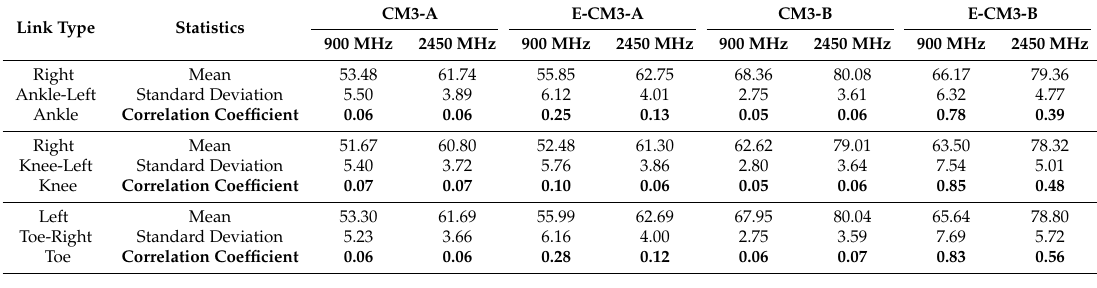
Table 7. Statistical analysis of the IEEE 802.15.6 channel models and enhanced proposed channel models using the deterministic approach.